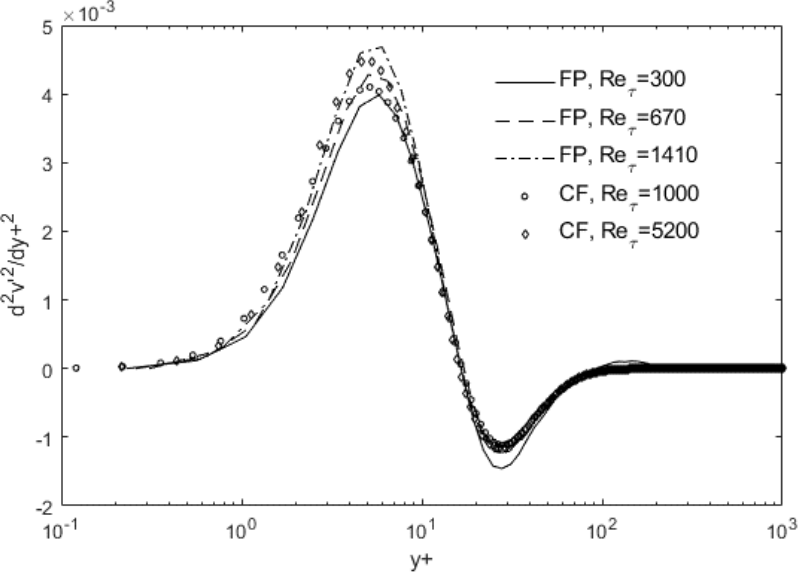
Figure 3. The dissipation scaling of d 2 v’ 2 /dy+ 2 . The near-wall peaks increase and the negative undulations increase in magnitude with the increasing Reynolds number. DNS data of Spalart [13] for FP and Graham et al. [12] for CF are used.